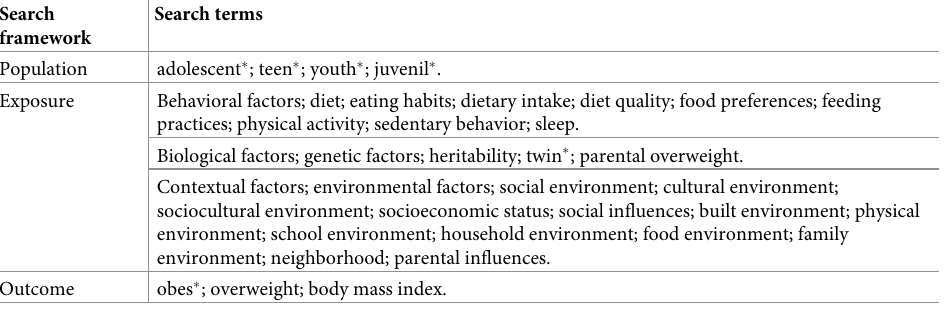
Table 1. Search terms of the population, exposure and outcome used in PubMed and